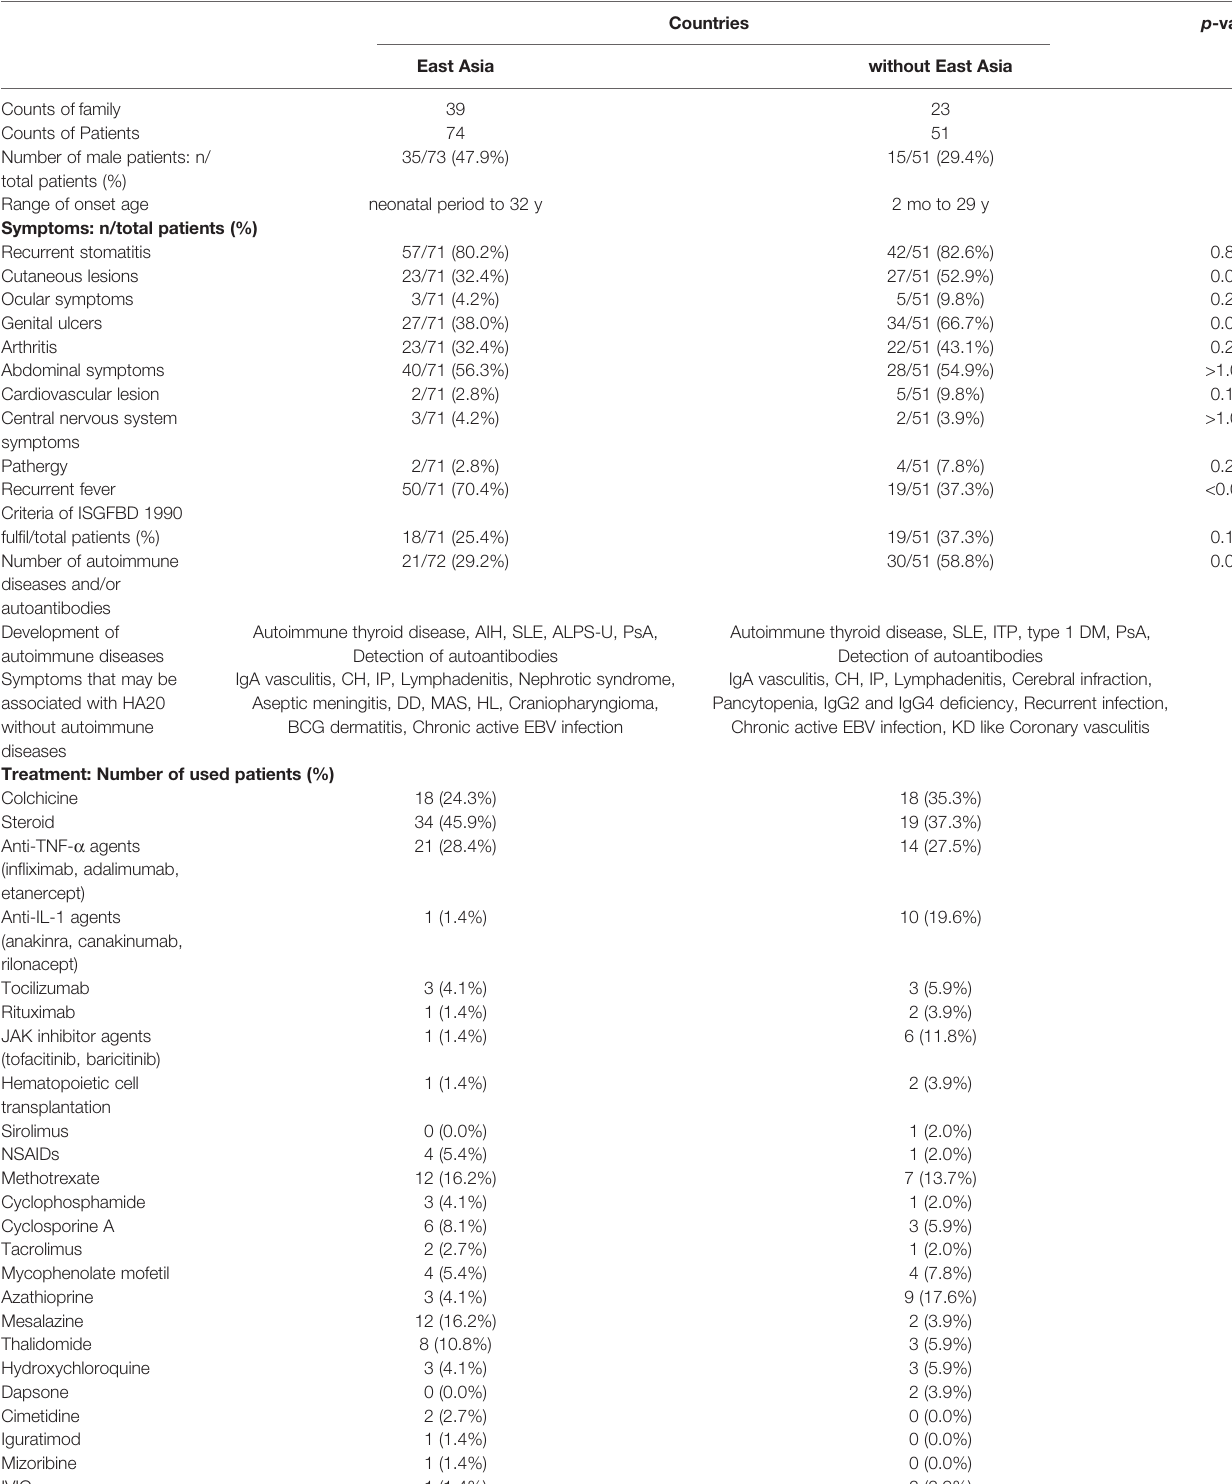
TABLE 1 | The comparison of symptoms and treatment between East Asia versus other